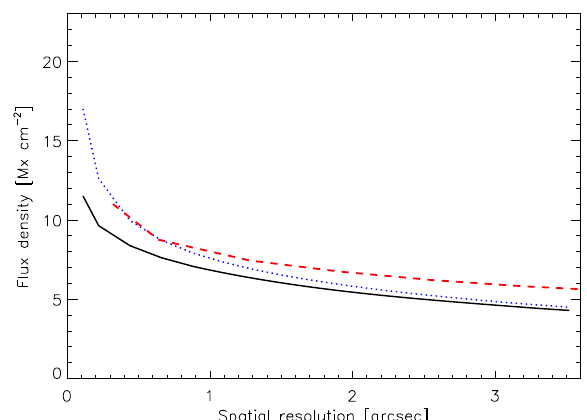
Fig. 26 Variation of the longitudinal magnetic flux density with spatial resolution calculated using SUN- RISE/IMaX data (solid and dotted) and Hinode/SP observations (dashed). The longitudinal flux density values were computed taking into account all the pixels within the field of view except for the dotted line, in which only pixels with circular polarization signals exceeding twice the noise level of the data at original resolution have been